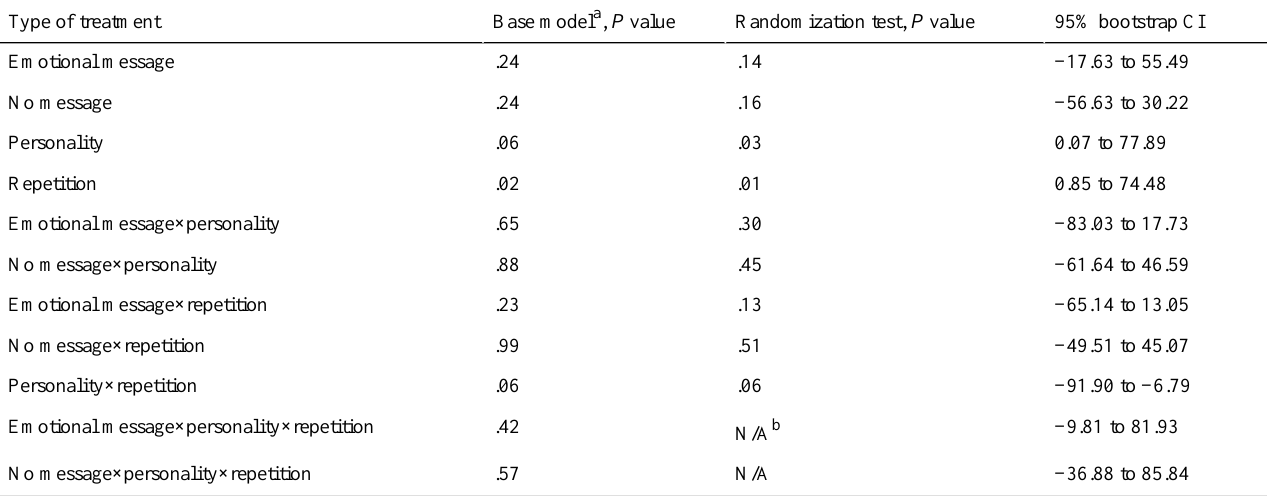
Table 4. Comparison of resampling